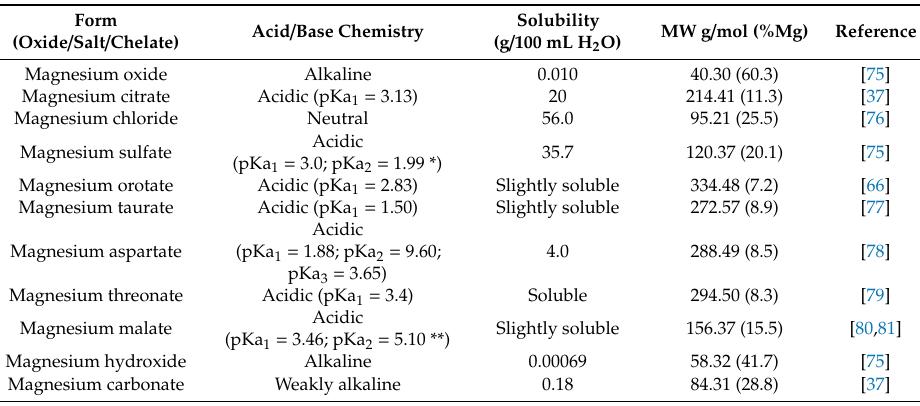
Table 3. Common magnesium supplements and their solubilities. Table includes pKa values for the terminal carboxylic proton (pKa 1 ) and the amino proton (pKa 2 ). Backbone protons are displayed as pKa 3 . The asterisk (*) represents the pKa of the first and second protons to be lost from the diacid sulfuric acid and the subsequent anion bisulfate, and the double asterisk (**) represents the pKa of the proton farthest from the backbone alcohol of the dicarboxylic acid malic